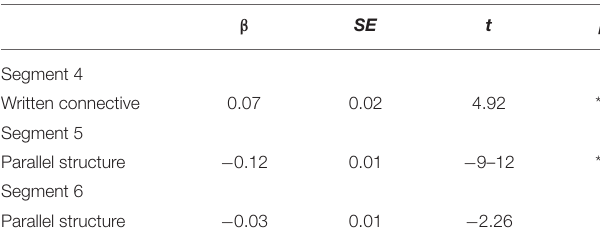
TABLE 6 | Model of the L2 data on segments 4, 5, and 6 (Experiment 2).